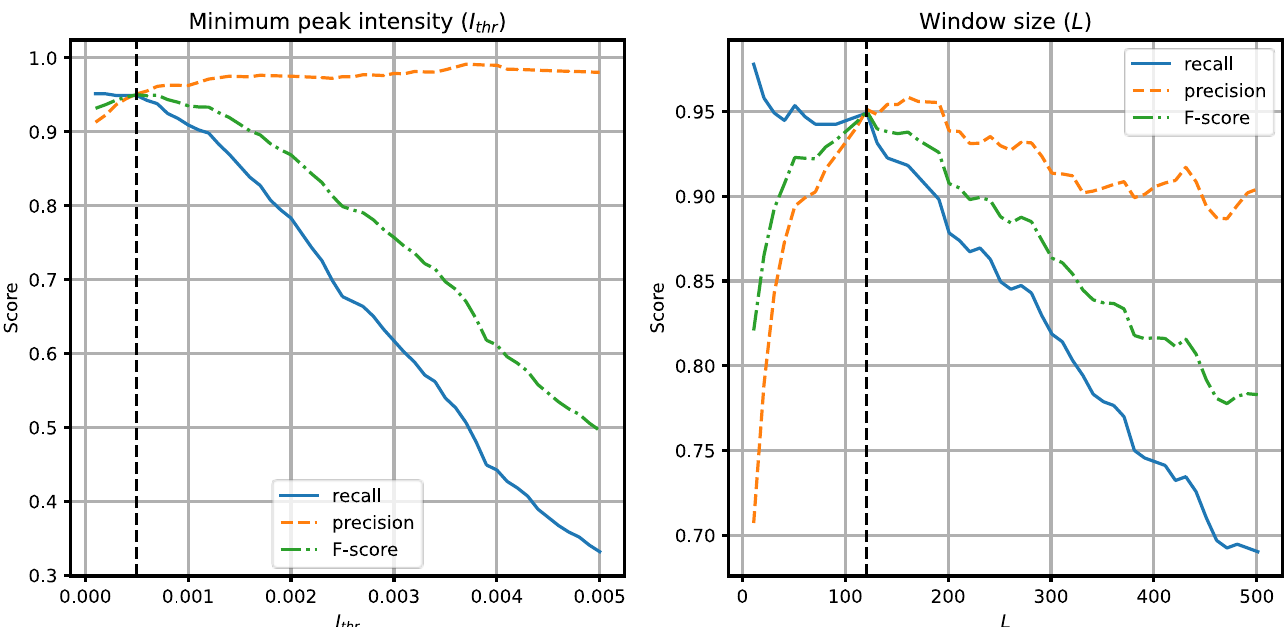
Figure 11. Optimization of the algorithm parameters: N thr and L . The vertical dashed lines indicate the values chosen for the experiments.